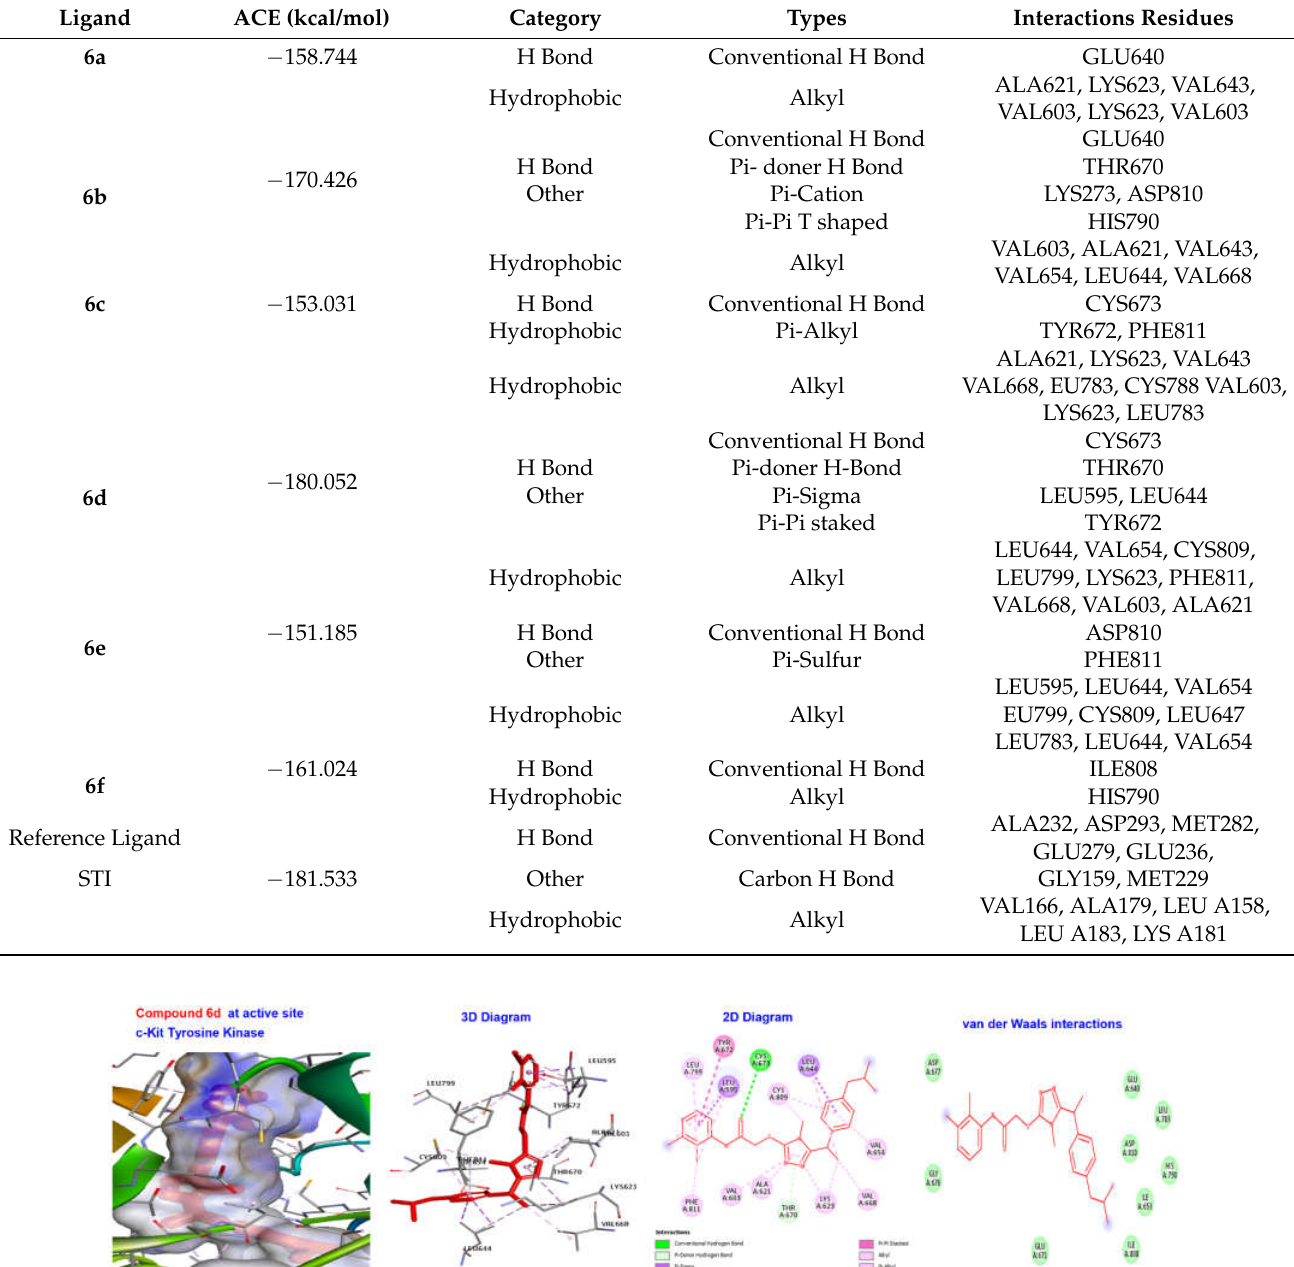
Figure 7. Binding pocket of docked ligand 6d in active site of c-Kit Tyrosine Kinase. The molecule 6b bound to Protein c-Kit Tyrosine Kinase by forming H-bond inter- actions with Glu640 and Thr670. Other key interactions involved hydrophobic alkyl interactions with the residues Val603, Ala621, Val643, Val654, Leu644 and Val668 (Figure